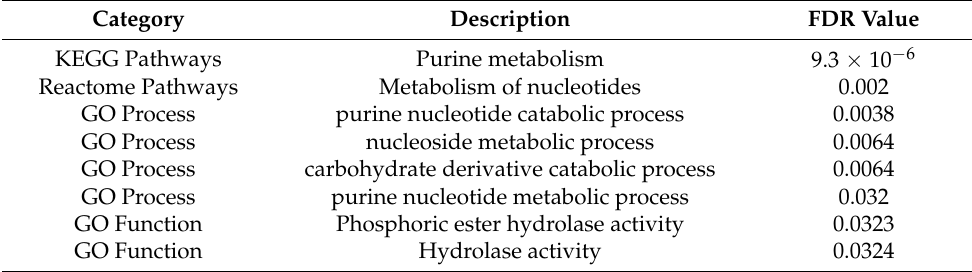
Table 4. Functional enrichment of the second subcluster of the PPI